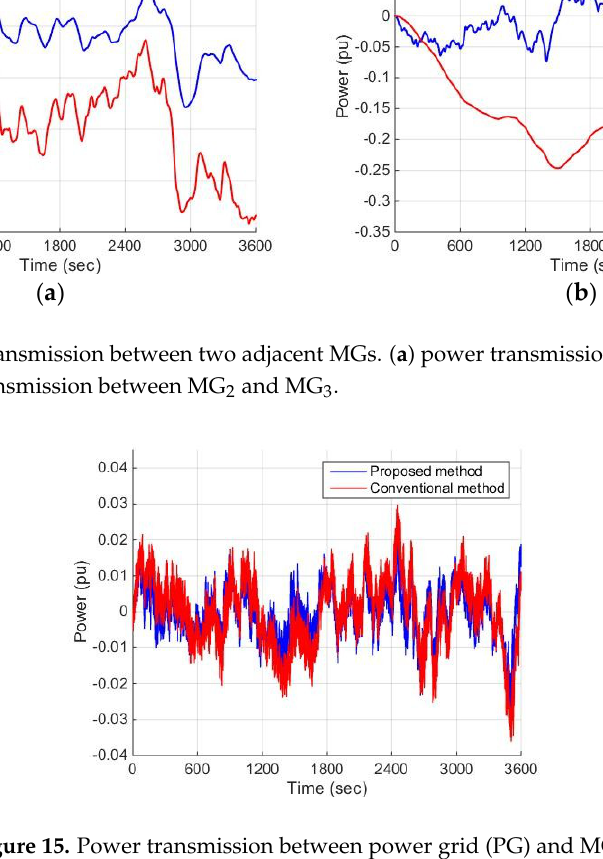
Figure 15. Power transmission between power grid (PG) and MG 1